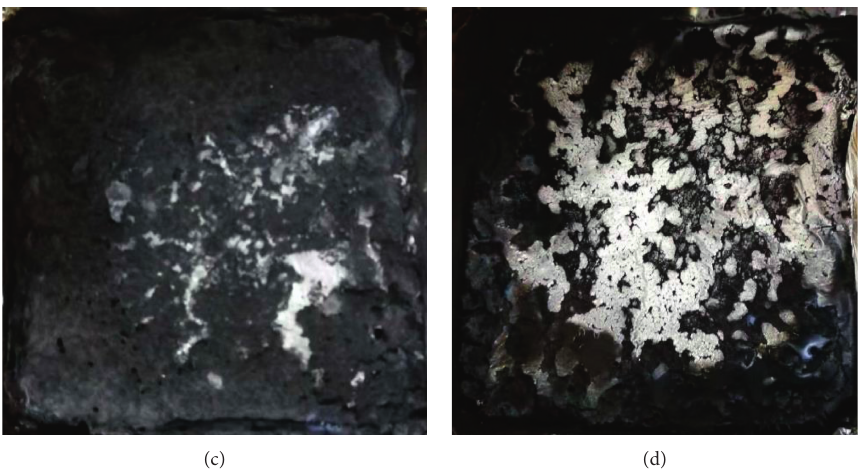
Figure 7: Photos of the residues obtained in CCT. (a) Sample-1. (b) Sample-2. (c) Sample-4. (d) Sample-6.